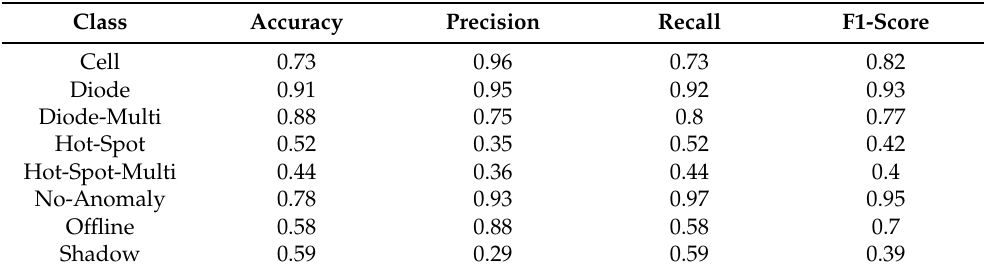
Figure 5. The confusion matrix of the proposed method based on K = 8. Table 3. The performance of each class based on K-means combined when K = 8.